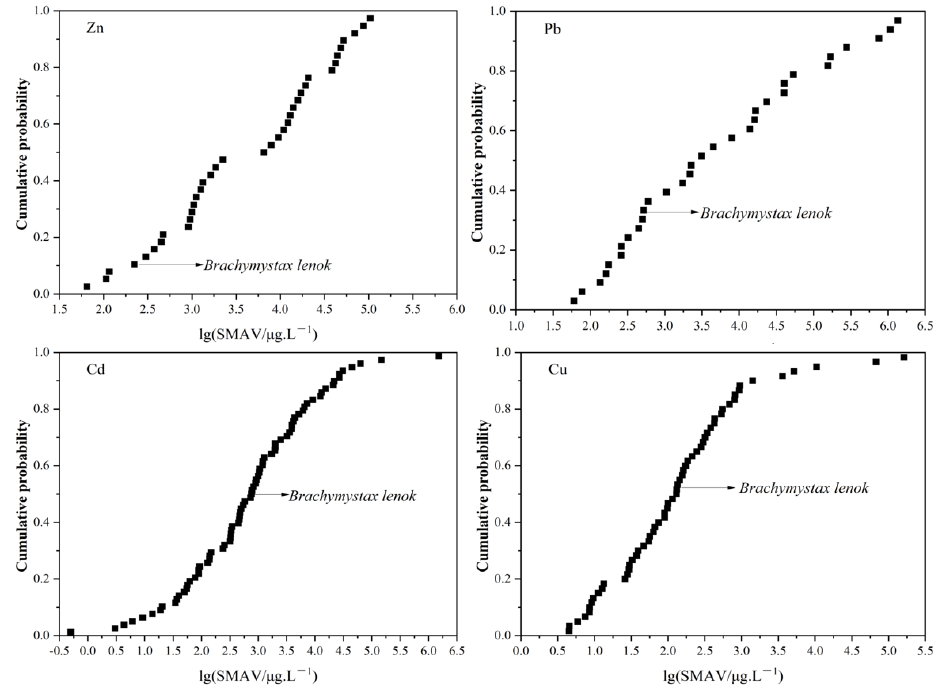
Figure 2. Species sensitivity distributions for the four heavy metals, across Chinese native species. Table 3. The sensitivity of B. lenok to the four heavy metals in comparison to other Chinese native species. Pollutant Order Total Number of Species Cumulative